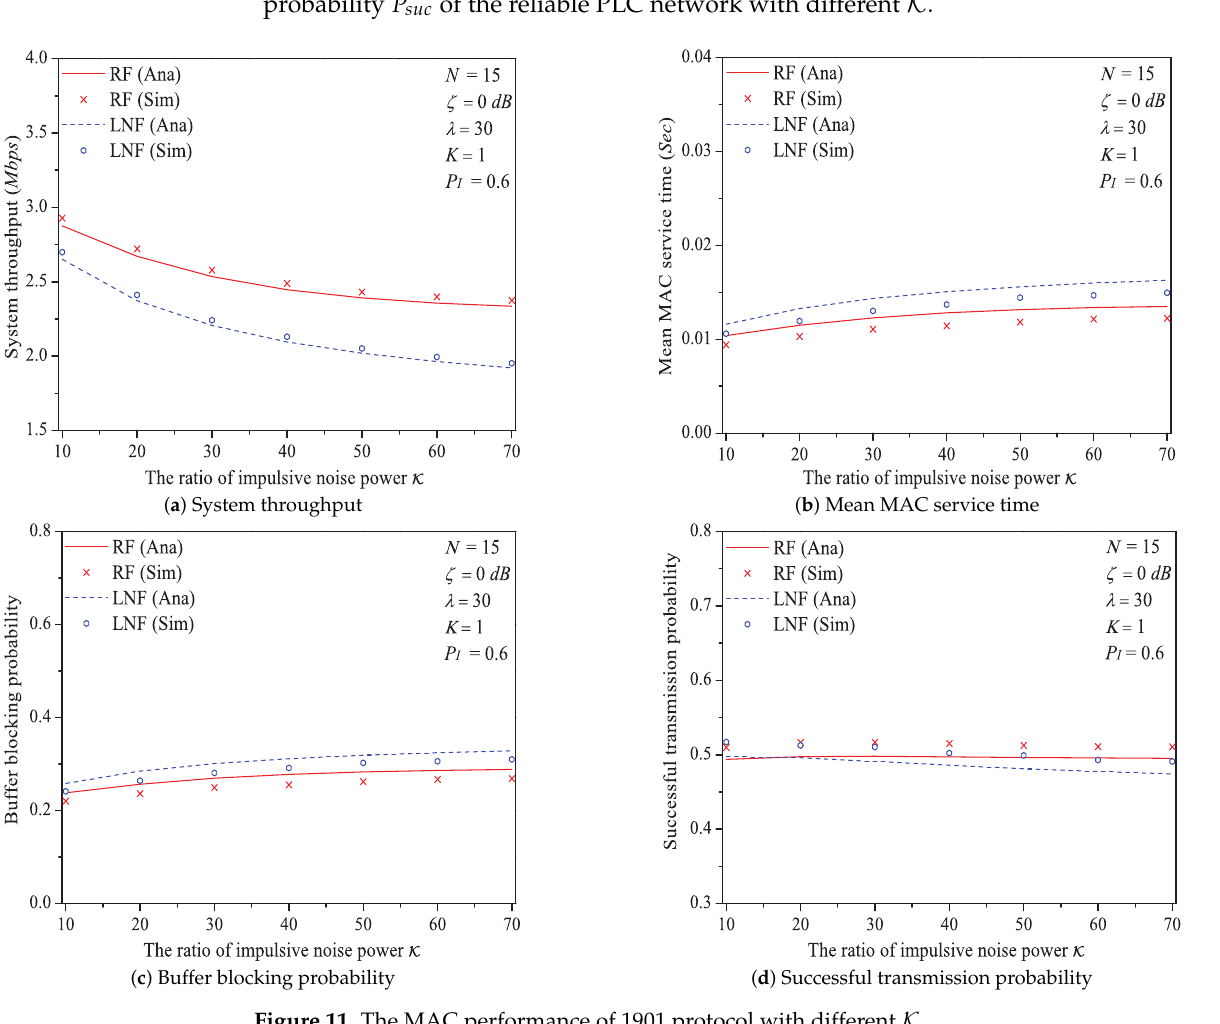
Figure 11. The MAC performance of 1901 protocol with different K